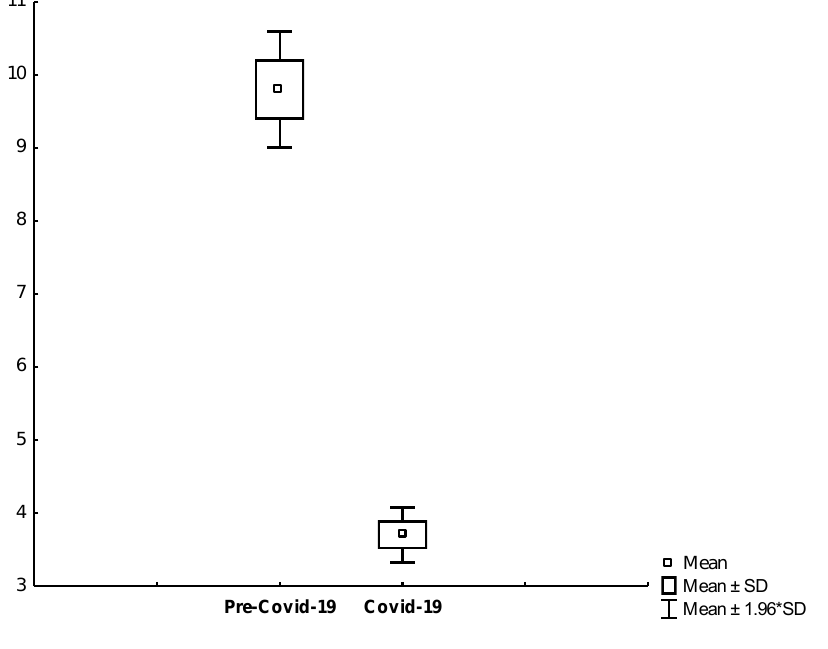
Figure 3. The comparison of the number of daily steps in the analyzed periods among young par- ticipants ( p < 0.001).